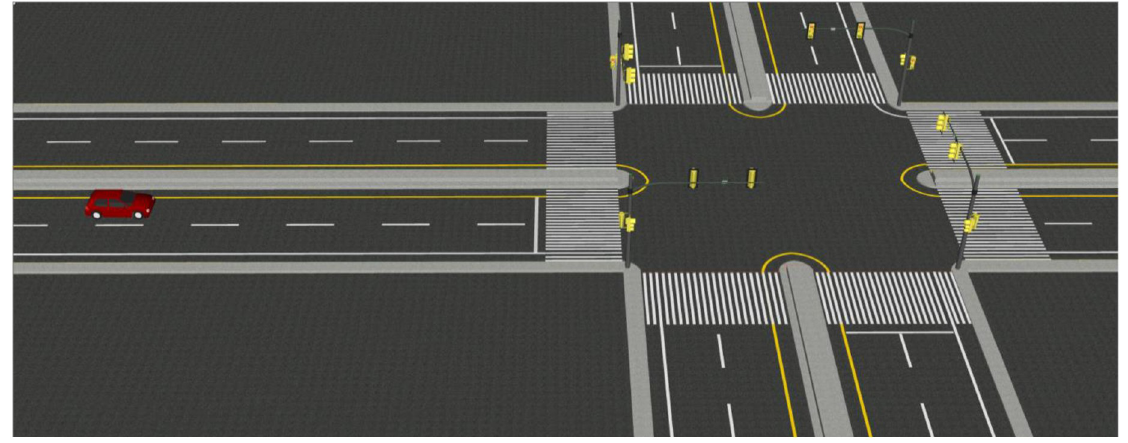
Fig 3. The snapshot of traffic